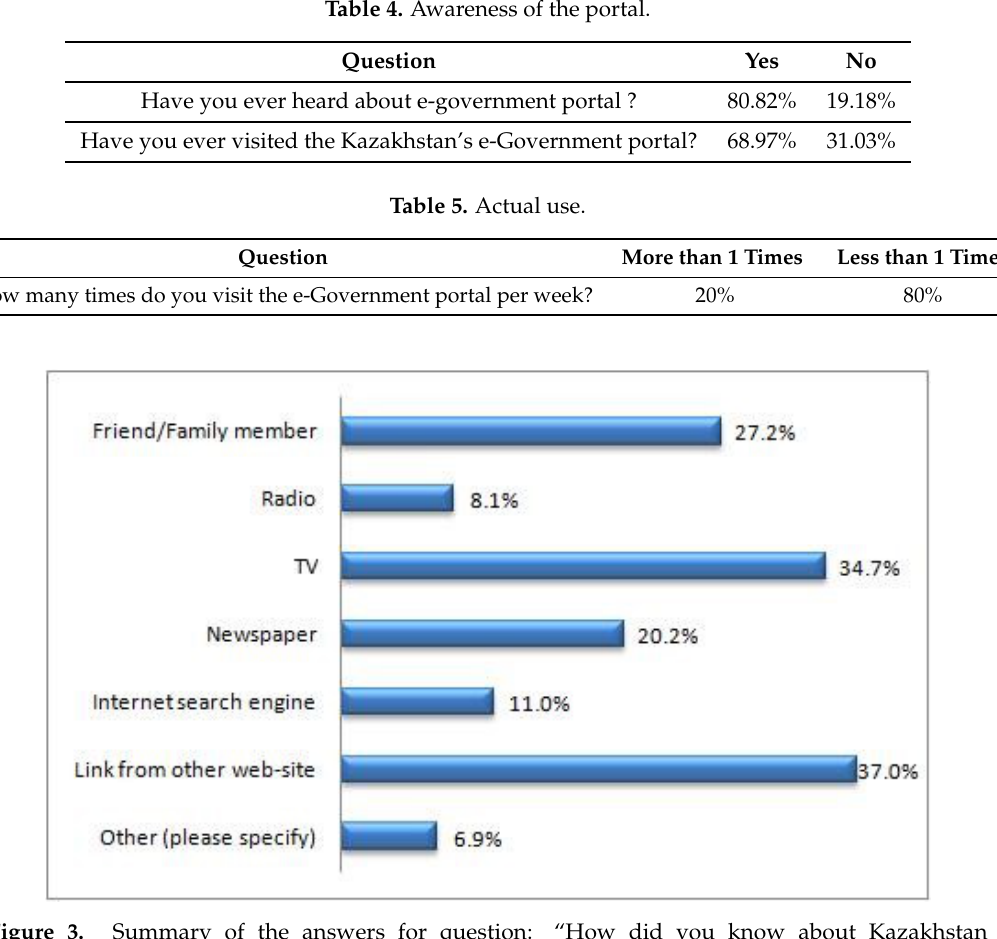
Figure 3. Summary of the answers for question: “How did you know about Kazakhstan e-Government